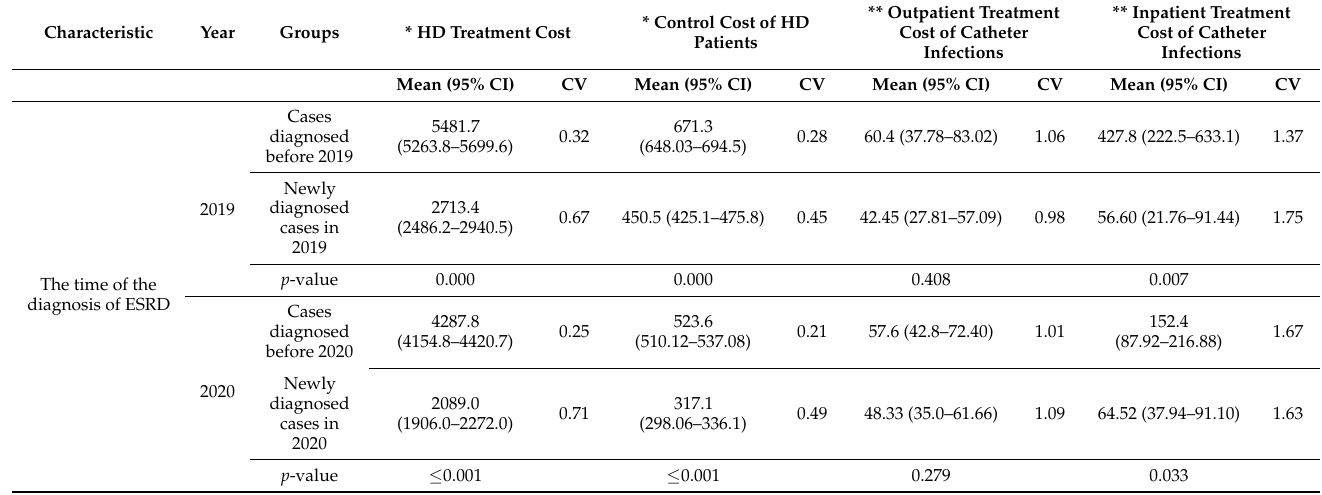
Table 6. Comparative analysis of characteristics information and costs values ($) of two different time periods (in 2019 and in